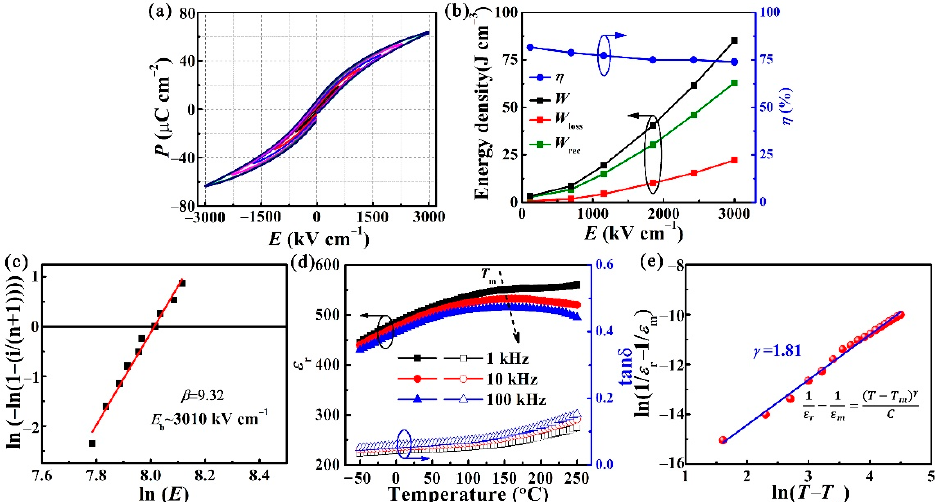
Figure 2. ( a ) The P-E loops for BST/0.4BFO-0.6STO under various applied electric fields. ( b ) The calculated W , W rec , W loss and η values as functions of the electric field. ( c ) Two-parameter Weibull analysis of dielectric breakdown strength. ( d ) Temperature-dependent ε r and tan δ under the frequency range of 1 kHz–100 kHz and the temperature range from − 50 to 250 °C. ( e ) ln(1/ ε r − 1/ ε m ) as a function of ln( T − T m ).